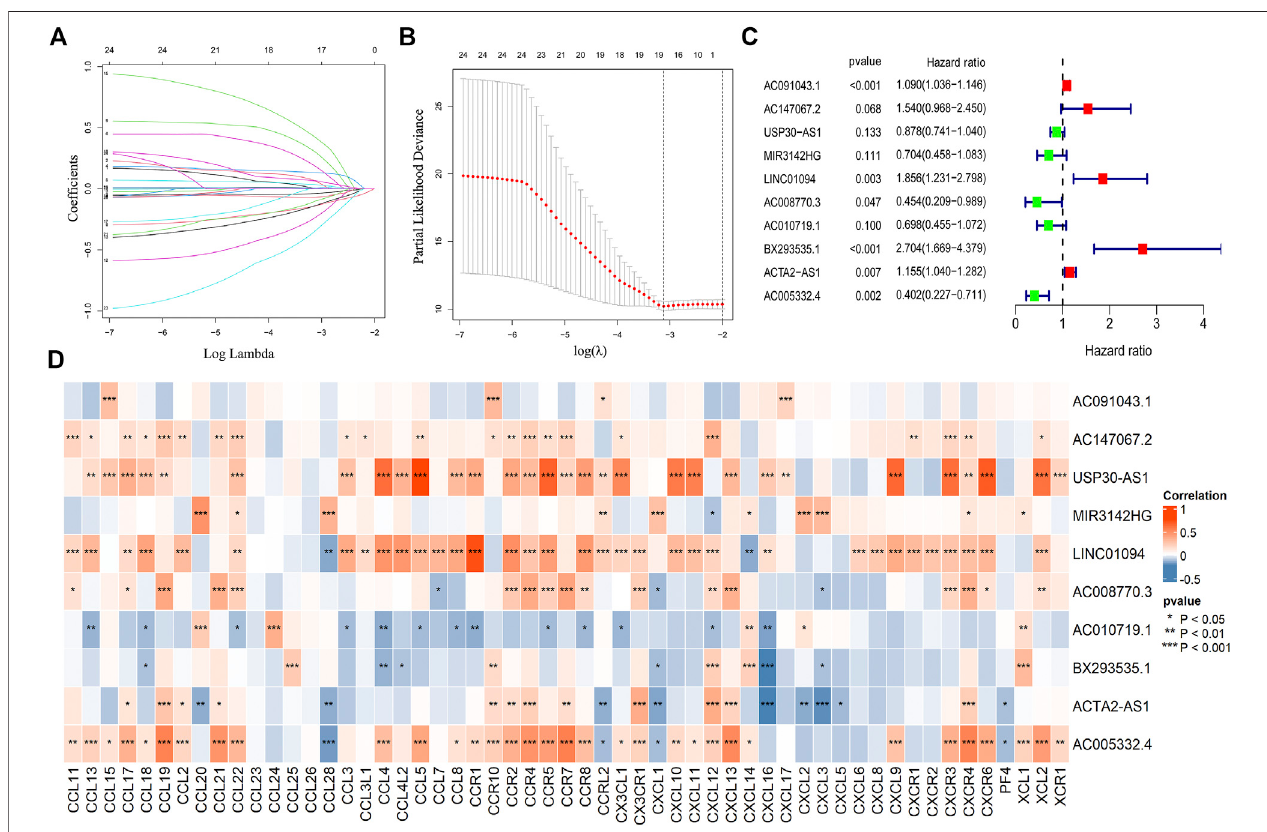
FIGURE 2 | Construction of the risk model. The lasso regression analysis (lasso) was conducted for the construction of the risk model (A,B) . A total of 10 chemokine-related lncRNA were identi fi ed in the risk model (C) . The correlation between chemokines and lncRNAs in the risk model (* p < 0.05, ** p < 0.01, *** p < 0.001) (D)